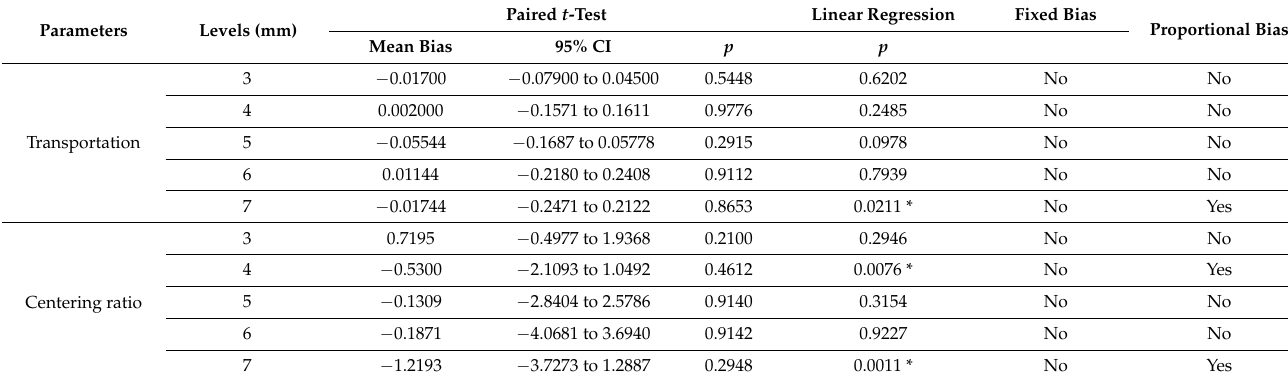
Table 2. Mean bias, confidence intervals, p values in two statistical tests, fixed or proportional bias at each level for the transportations and centering ratios of the two methods’ measurements in the bucco-lingual direction.